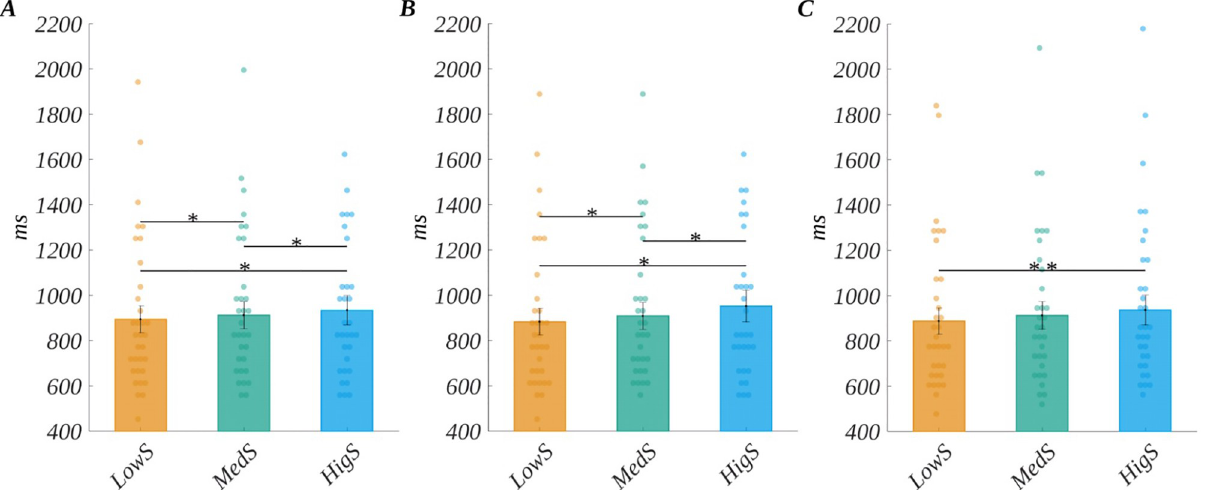
Fig 2. Effects concerning reaction time. (A) The main effect of subjective significance. (B) Interaction between origin and subjective significance for words of no specific origin (Null). (C) Interaction between origin and subjective significance for reflective words. Bars represent the mean value, error bars SEM, individual dots mark the average response time of an individual subject in the given condition, black horizontal lines indicate pairs of conditions with significantly different means ( �� p < .01, � p < .05).